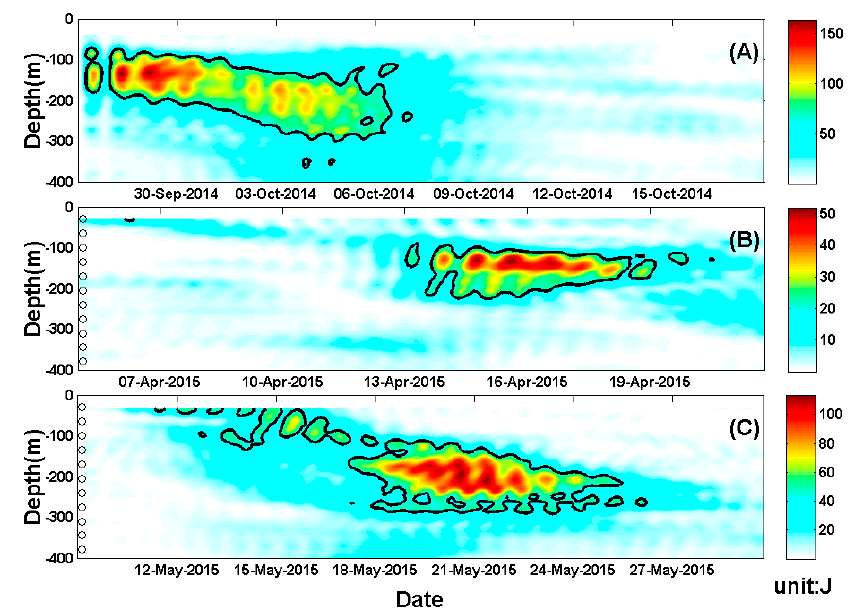
Figure 5. Time evolution of the band-pass ( σ ∈ [0.7,1.2] f ) filtered near-inertial kinetic energy (NIKE) (in J). The horizontal axis of the figure is time. The vertical axis is the water depth with the unit m. The thick black lines are 1/ e of the maxima NIKE. The black circles indicate the times the typhoons were closest to the mooring. NIKE below 400 m was too weak and not shown in this figure. For the three pictures to be presentable, the three colorbars are different.